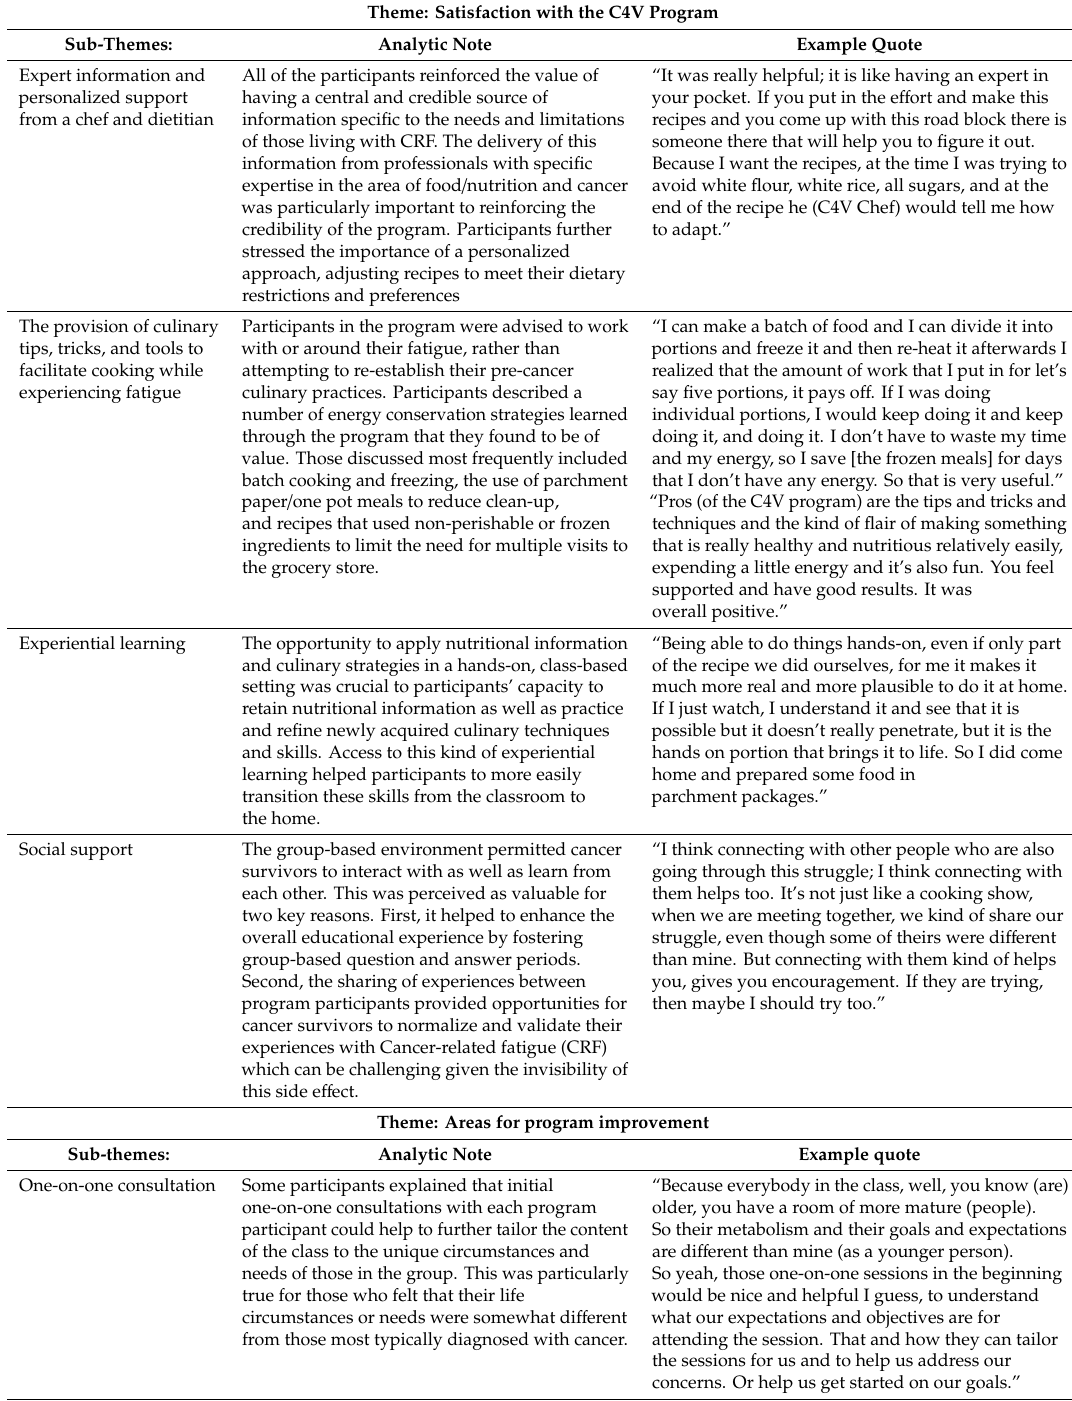
Table 3. Qualitative table for